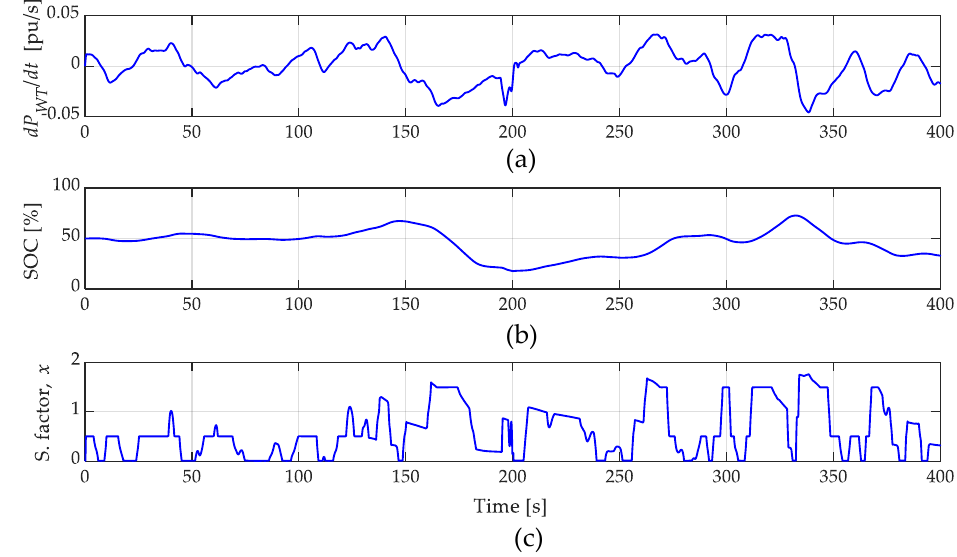
Figure 11. Input and output variables to the fuzzy logic controller. ( a ) dP WT / dt dynamics, ( b ) state of charge of the SC–ESS and ( c ) adjusting of the smoothing factor in real time.